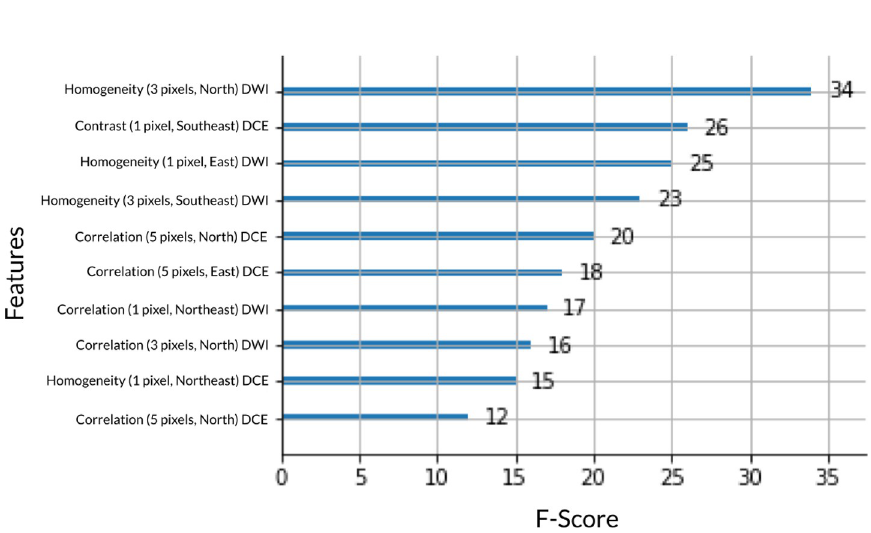
Fig 5. Top 10 most important texture features out of 372 features by F-score. GLCM features are shown with pixel distance value (1, 3 or 5 pixels), direction (North/South, East/West, North East/South West, or North West/South East), and MRI imaging type (DCE: dynamic contrast enhanced or DWI: diffusion-weighted imaging). GLCM: gray- level co-occurrence matrix.